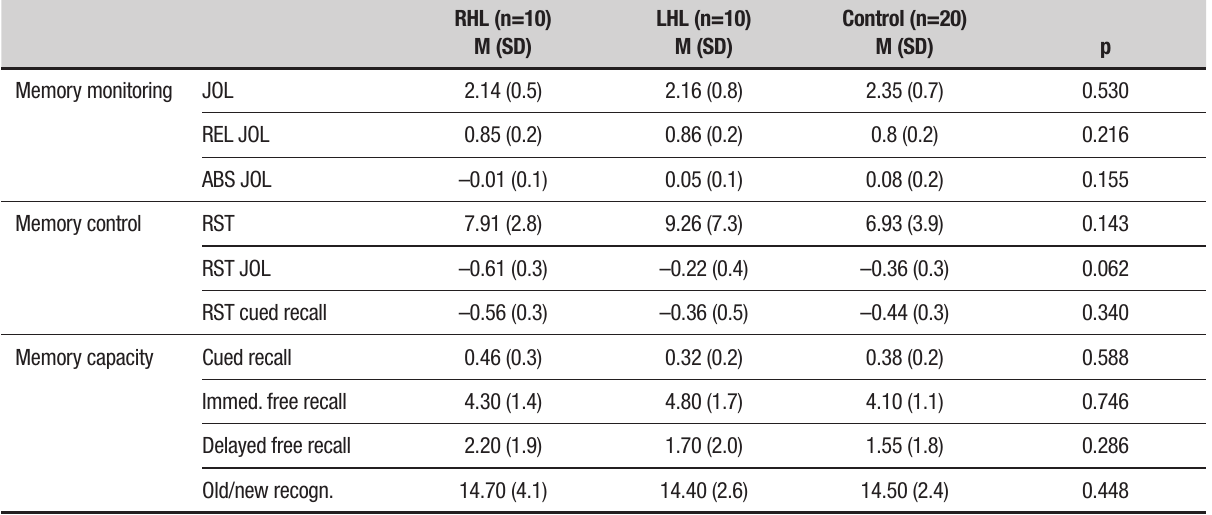
Table 4. Comparison of performance on memory monitoring, control and capacity scores between groups